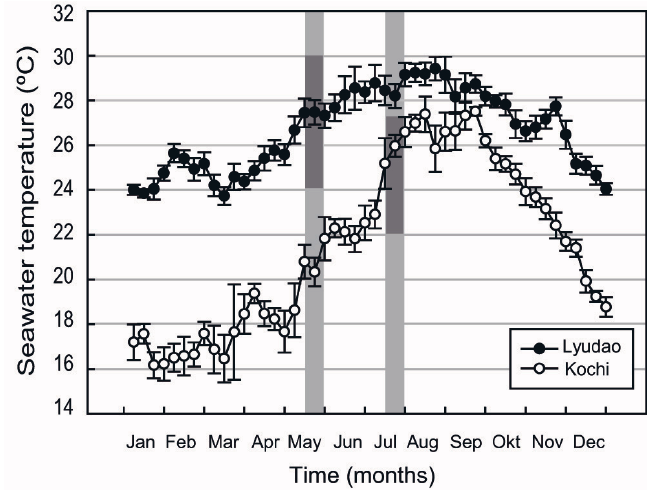
Figure 2. Seawater temperature (weekly averages ± SD) in 2011 at the study locations in Lyudao (Guei-wan 5 m depth) and Kochi (Nishidomari 5 m depth). The light grey zones indicate the spawning periods in May (for Lyudao) and July (for Kochi). The dark grey zone accentuates the temperature during the main spawning period at each location (April–June in Lyudao; July–August in